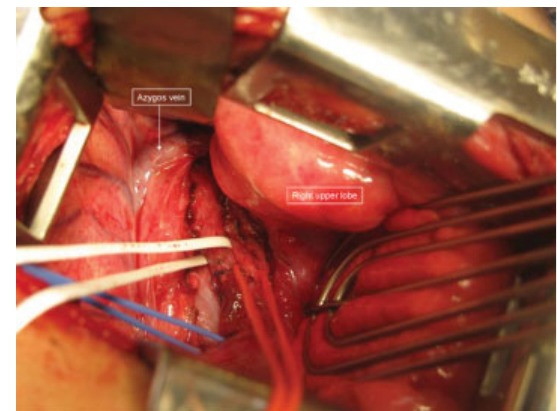
Fig. 3 Intraoperative photograph with the ectopic right lower lobe bronchus (white loop) with its respective artery (red loop) and vein (blue